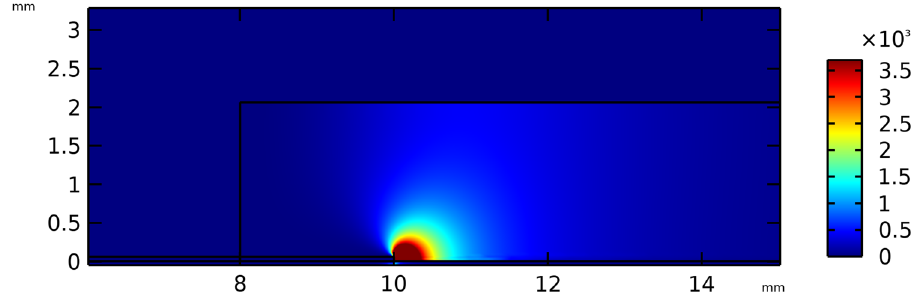
Figure 14. Spatial distribution of the horizontal body force component calculated based on the presented numerical model.